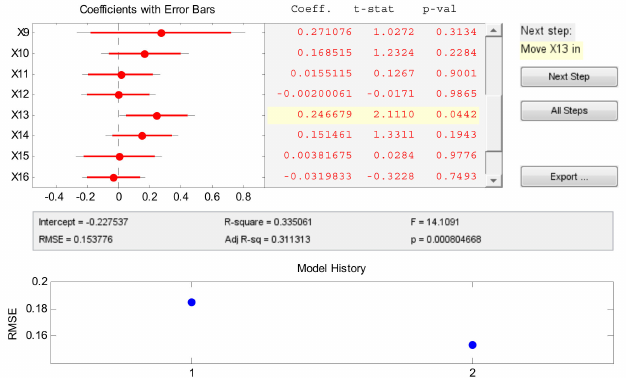
Figure 5. The interface of the stepwise function in MATLAB.